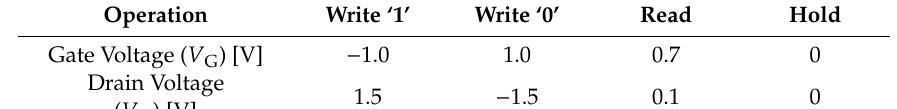
Table 1. Bias conditions for memory operations.